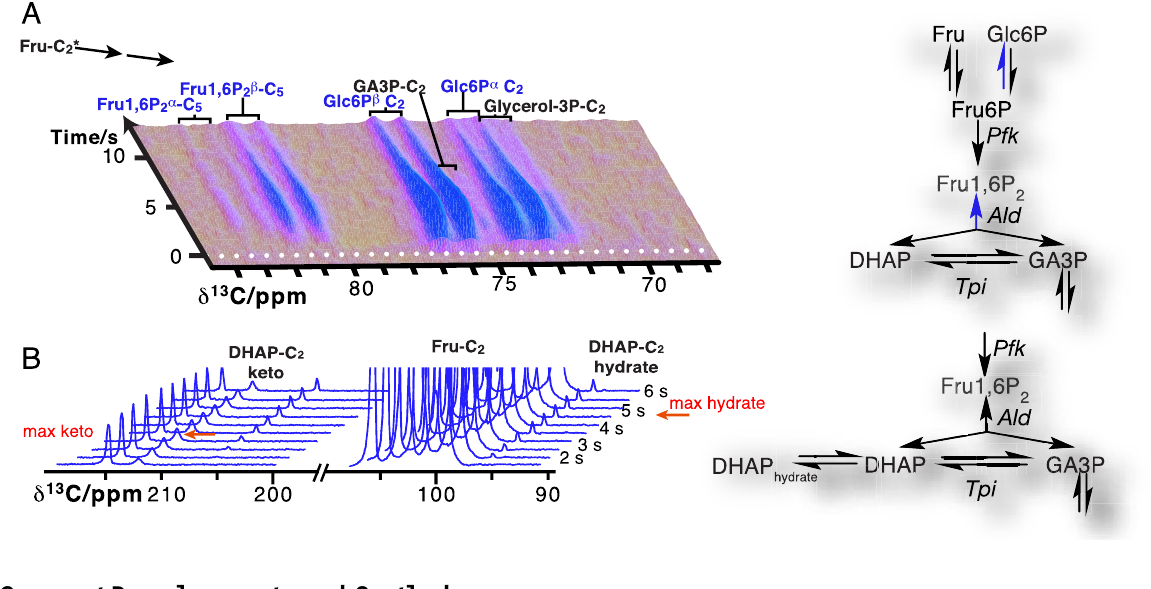
Figure 6. Time-resolved observation of metabolite isomers upon feeding a hyperpolarized [2- 13 C]fructose probe to a Saccharomyces cerevisiae cell cultures at time 0: ( A ) Glucose 6-phosphate (Glc6P) and fructose 1,6-bisphosphate (Fru1,6P gluconeogenic reactions of the glycolytic substrate. Isomer ratios are consistent with the formation of the isomers from acyclic intermediates; ( B ) real-time observation of dihydroxyaceyone phosphate (DHAP) hydrate formation as an off-pathway glycolytic intermediate (other abbreviations are: GA3P = glyceraldehyde 3-phosphate, Ald = aldolase; Pfk = phosphofructokinas e ; Tpi = triose phosphate